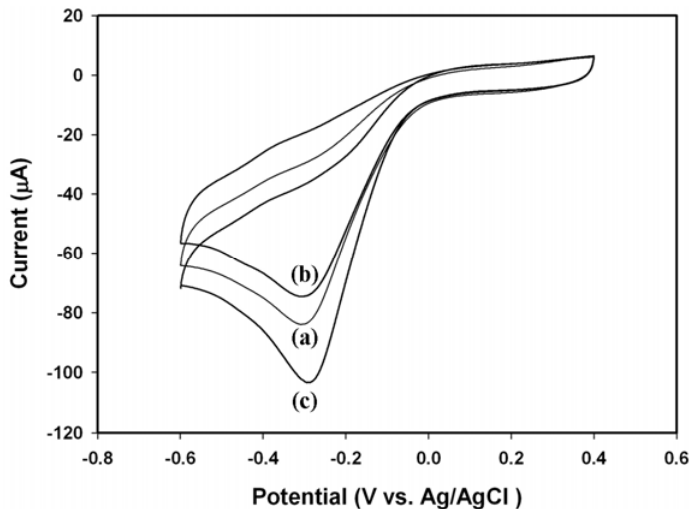
Figure 5. The cyclic voltammograms of: (a) PANI/Pt, (b) GA/SBA-15/PANI/Pt, and (c) GA/SBA-15(HRP)/PANI/Pt in response to 18.5 mM of H2O2 in 0.1 M phosphate buffer (pH 6.2) with a scan rate of 20